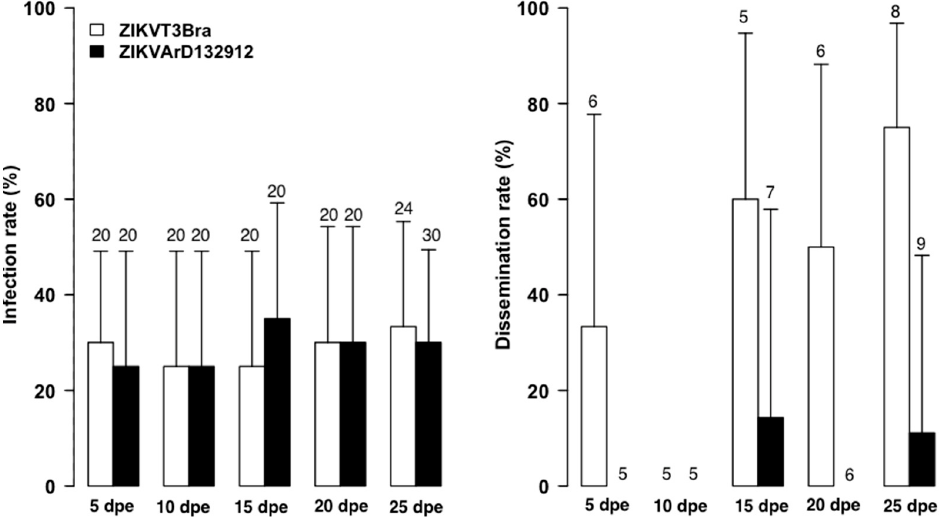
Figure 2. Infection and Dissemination Rates at 5, 10, 15, 20 and 25 dpe for Ae. aegypti from Senegal orally exposed to 10 4 PFU/mL of Brazilian ZIKV (ZIKVT3FBra) and Senegalese strains (ZIKV132912) freshly harvested from C6/36 cells. Values above each column mean the total number tested, nt = not tested.